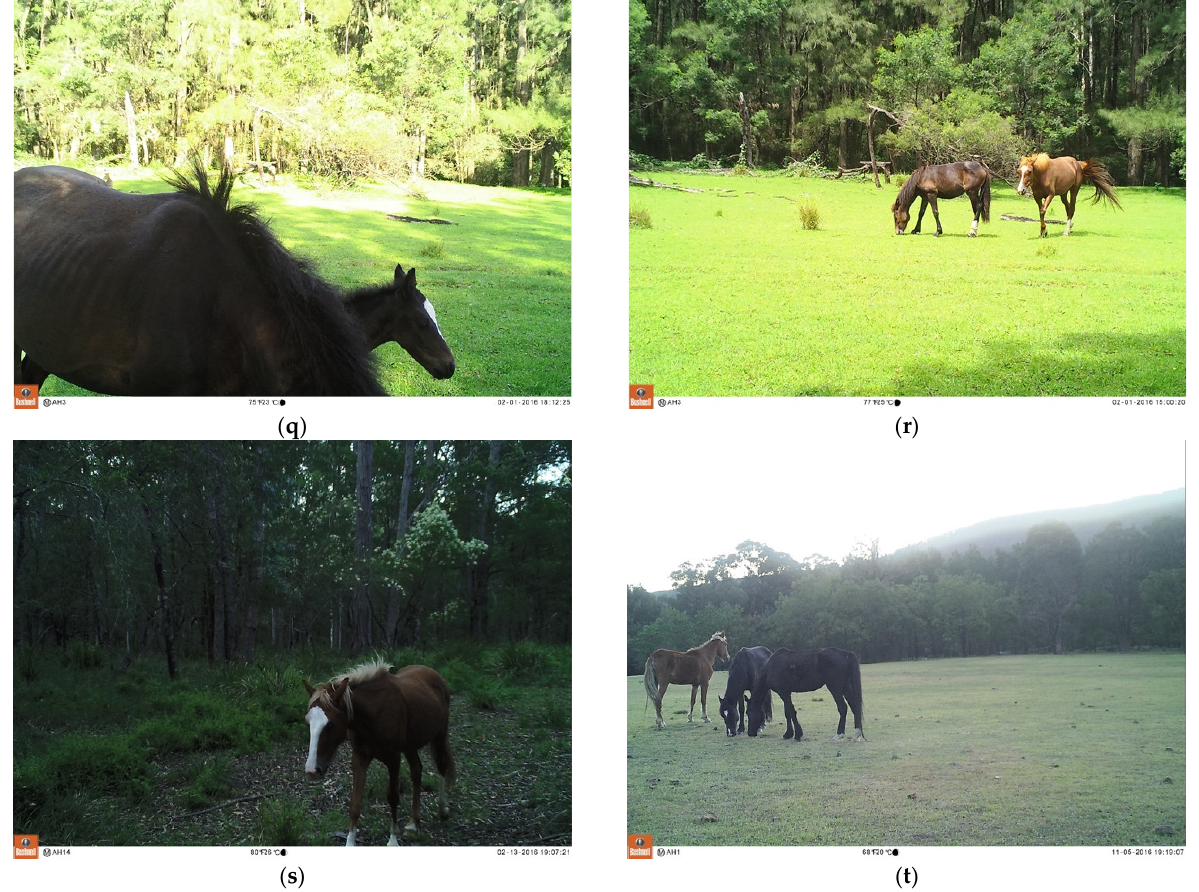
Figure 9. Examples of identification of horses, and assessment of welfare indicators with camera trap images, and common reasons for not being able to identify horses or assess indicators. ( a ) This horse was too close to the camera resulting in only the top half of the horse being in the image, therefore it was not possible to identify or assess welfare indicators other than body condition on this particular image. ( b ) Although this image was taken during daylight, shadowing from trees resulted in the image being too dark to identify the horse or welfare indicators. ( c ) A night-time image illustrating the difficulty in identifying horses or indicators in night-time images. ( d ) These horses’ distinctive markings make them iden- tifiable, and it can be determined that both horses are cantering, however blurring of the image means no other welfare indicators are able to be assessed. ( e ) This horse can be identified from its colour and hindlimb markings, and it is evident that the horse is grazing, but no other welfare indicators can be assessed due to only the back of the horse being visible. ( f ) This horse can be identified, and it is evident that the horse is walking; body posture, body condition, hoof condition and presence of limb pathology can be assessed, but other welfare indicators are unable to be assessed as the image is too dark. ( g ) This horse cannot be identified on this single image as the shape of the blaze is not evident from the side-on image, and the limb markings are obscured by the water. Body condition and presence of wounds on the right side can be assessed. ( h ) The horse on the left cannot be identified as only the rump and tail are in the image, however it is enough to ascertain that the horse on the right is not alone. The horse on the right can be identified from its limb markings, and is observed to be grazing but the image is too dark and the horse too distant from the camera to be able to assess any other welfare indicators. ( i ) This horse can be identified from his colour, limb markings, sex, and length of tail suggesting he is juvenile. It is evident that he is grazing, but he is too distant from the camera to enable assessment of other welfare indi- cators. ( j ) A closeup image of a horse just at the perfect distance and orientation to the camera to enable both its identifi- cation and assessment of all welfare indicators on the left side. ( k ) This horse is identifiable from her colour and distinctive facial marking, and it is evident that she is grazing. An appreciation of body condition is possible although an accurate assessment of body condition score cannot be made with the limited proportion of the body captured in the image, and she is too distant to the camera to be able to assess facial indicators accurately. No other indicators are able to be assessed from this image. ( l ) This horse is identifiable from her facial marking, and it is evident that she is cantering. Body posture and body condition can be assessed, but she is too distant from the camera to enable assessment of other welfare indicators. ( m ) This image captures four horses from Band 2 cantering together and illustrates close spatial proximity between them